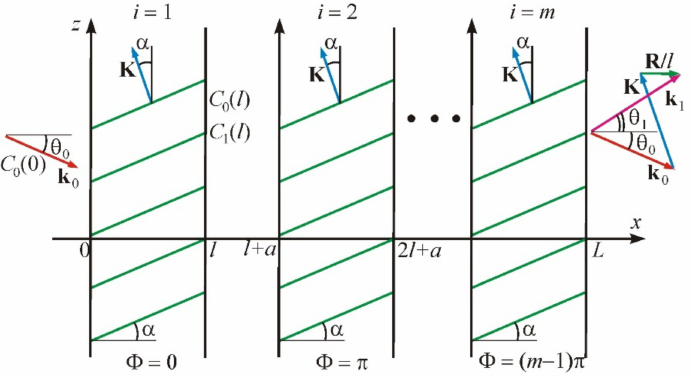
Figure 3. Statement of the problem of acousto-optic (AO) interaction in the field of the phased-array